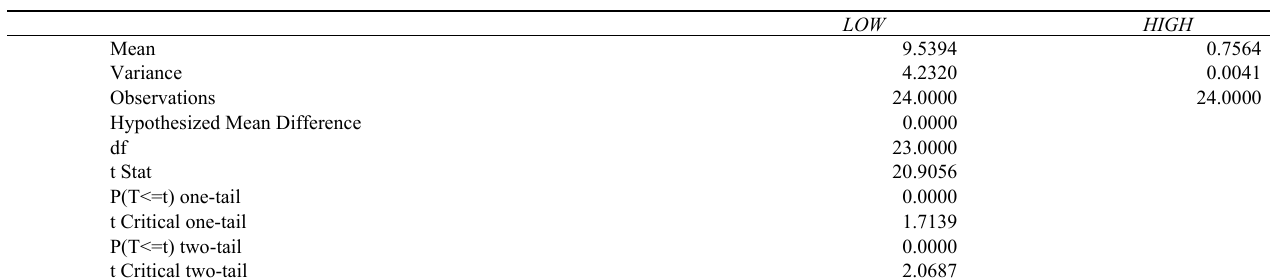
Hypothesis Testing between Bottom rating and High Rating (Naive diversification) t-Test: Two-Sample Assuming Unequal Variances